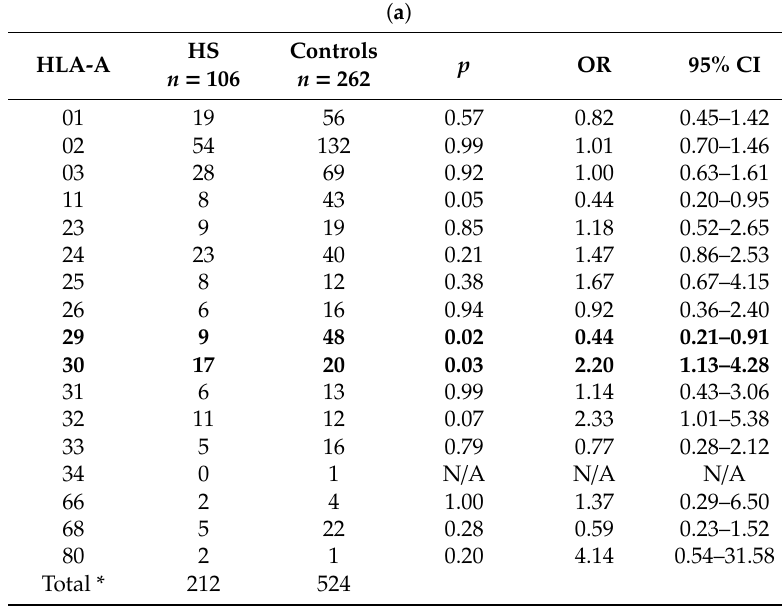
Table 1. HLA-A (a), -B (b), and -C (c) allele frequencies in HS (Hidradenitis suppurativa) patients and healthy